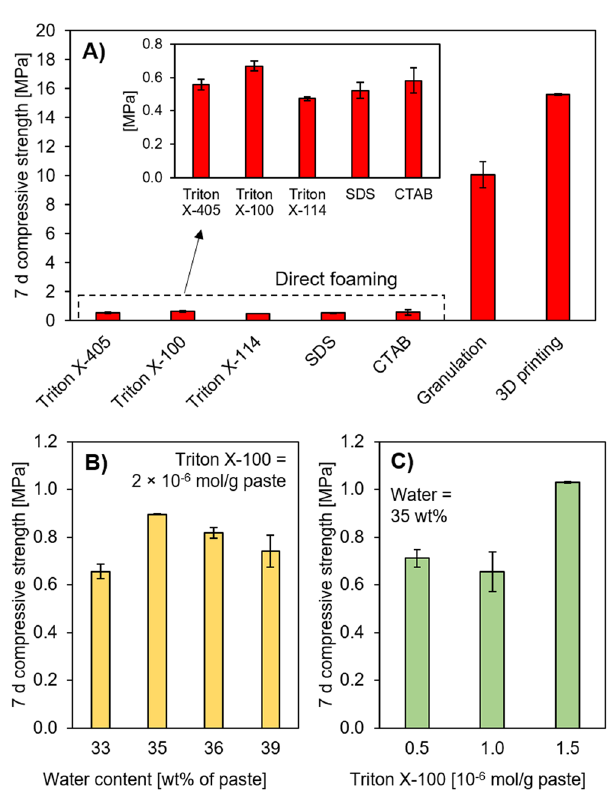
Figure 4. ( A ) Compressive strength (at 7 d age) of filter materials prepared with direct foaming, granulation, or 3D printing. ( B , C ) show optimization of water content and surfactant content with Triton X-100. Error bars represent ± standard error. SDS = sodium dodecyl sulfate and CTAB = cetyltrimethylammonium